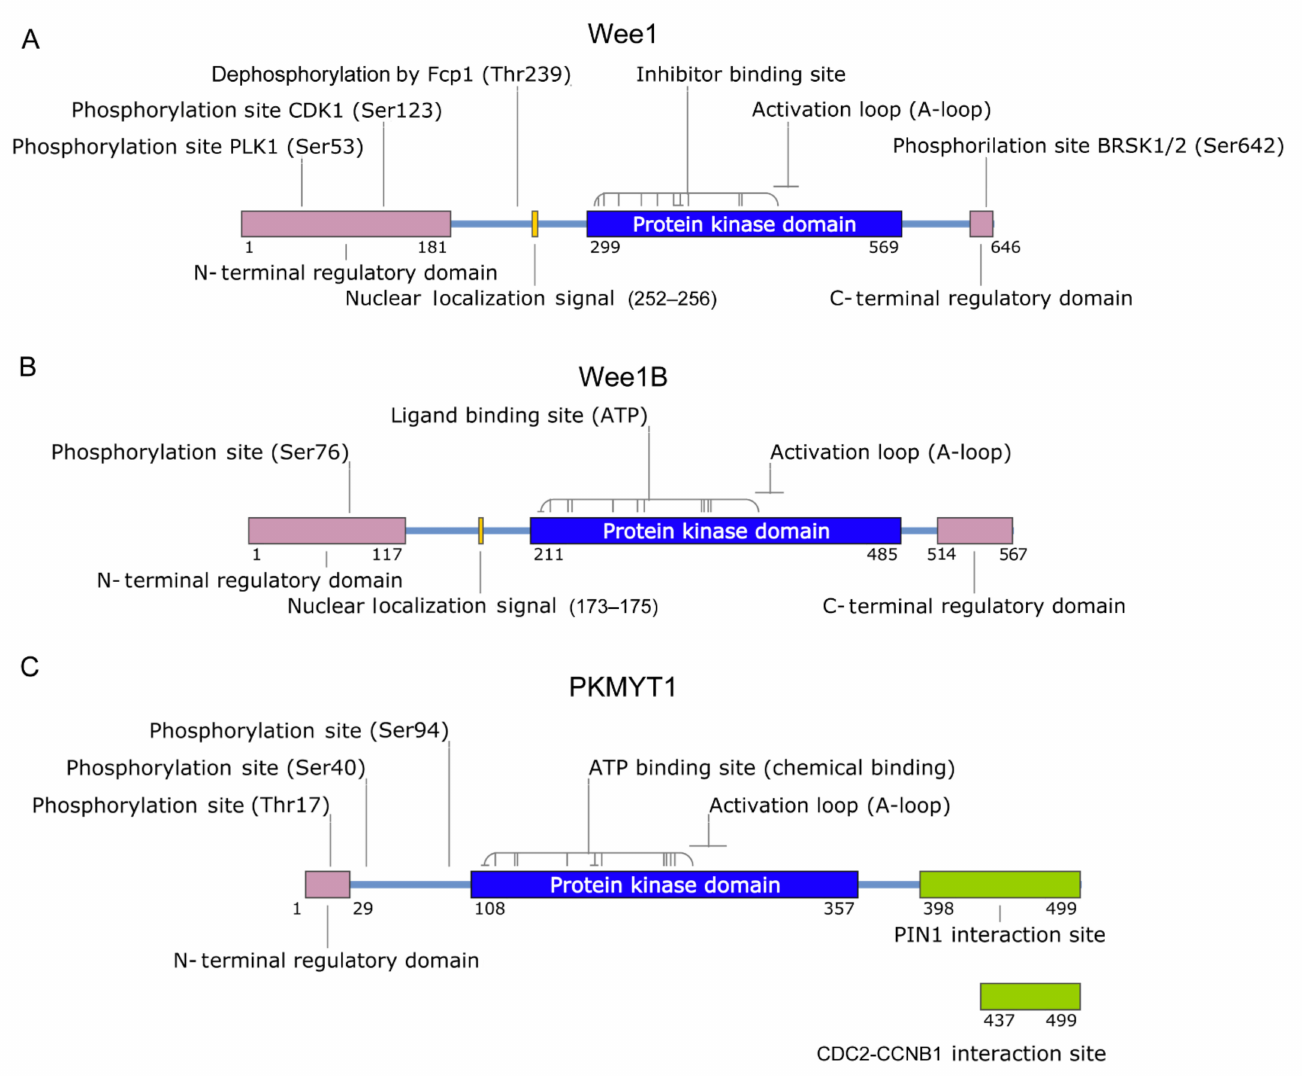
Figure 1. Schematic representation of Wee1 ( A ), Wee1B ( B ) and PKMYT1 ( C ) domain structures, interaction and post- translational modifications